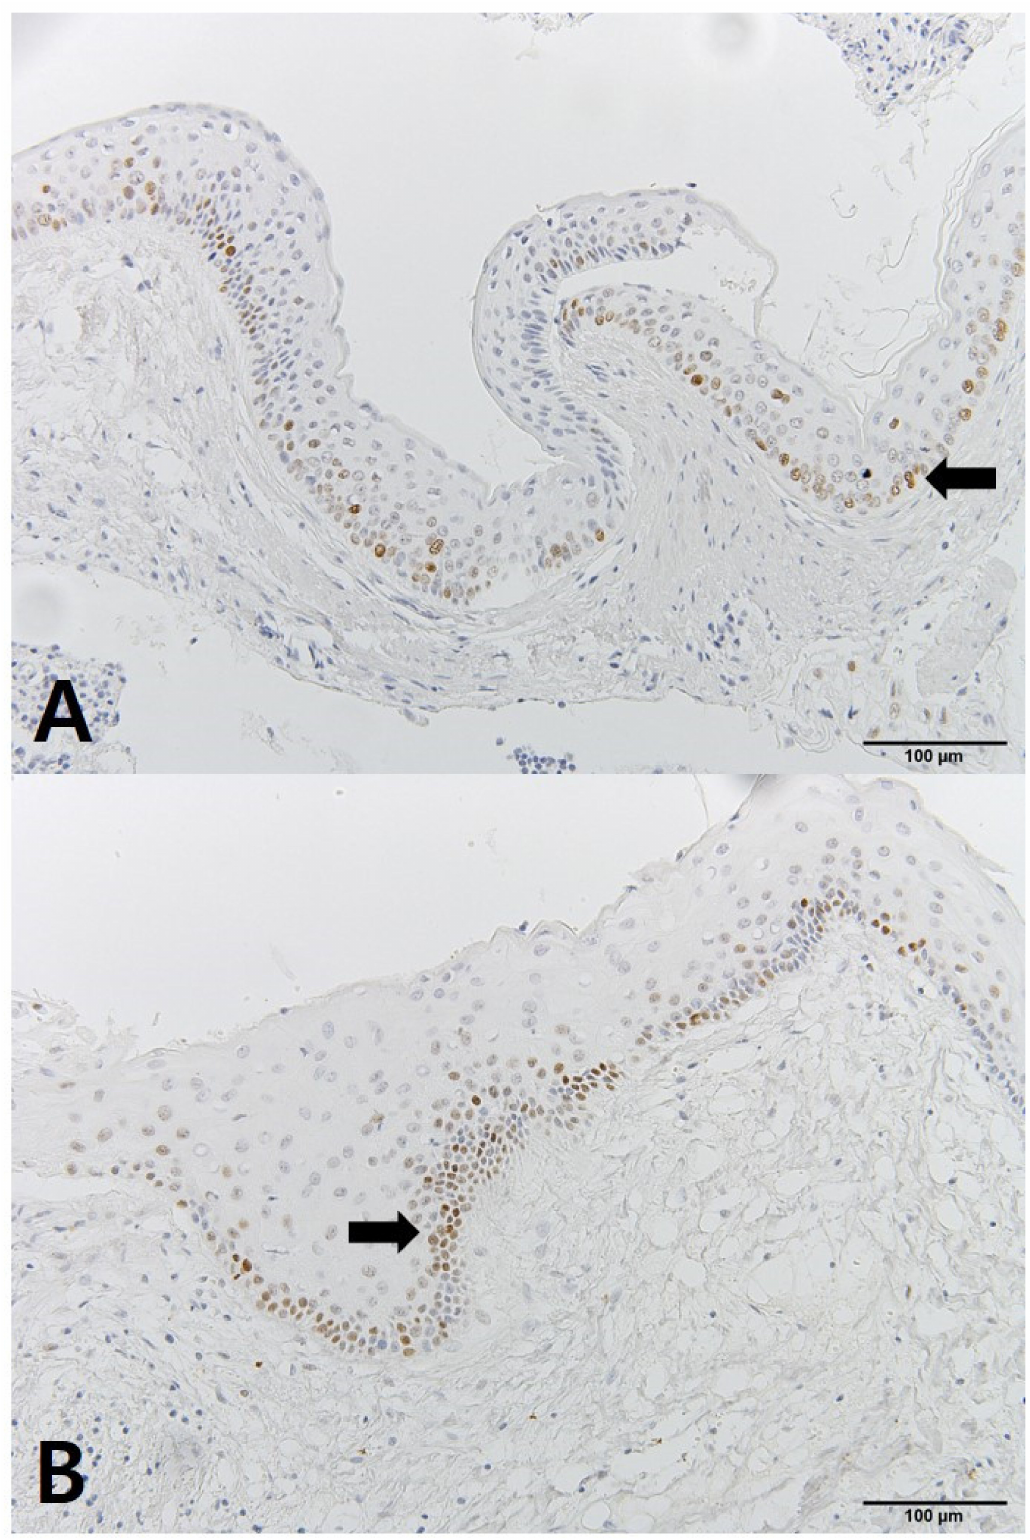
Figure 7. IHC staining of P53: ( A ) tissue obtained at decompression; ( B ) tissue obtained